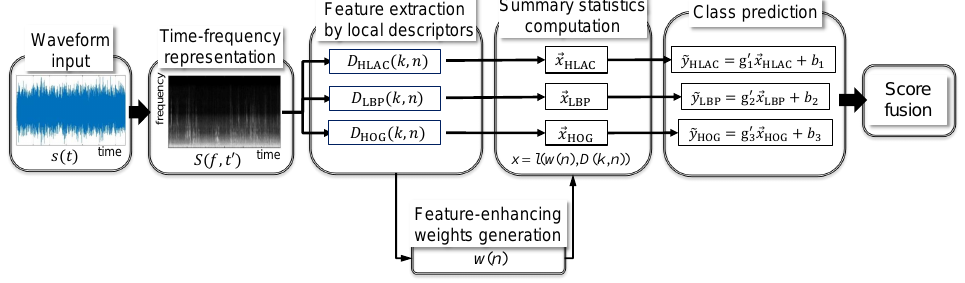
Figure 2. Flowchart of the proposed acoustic scene classification